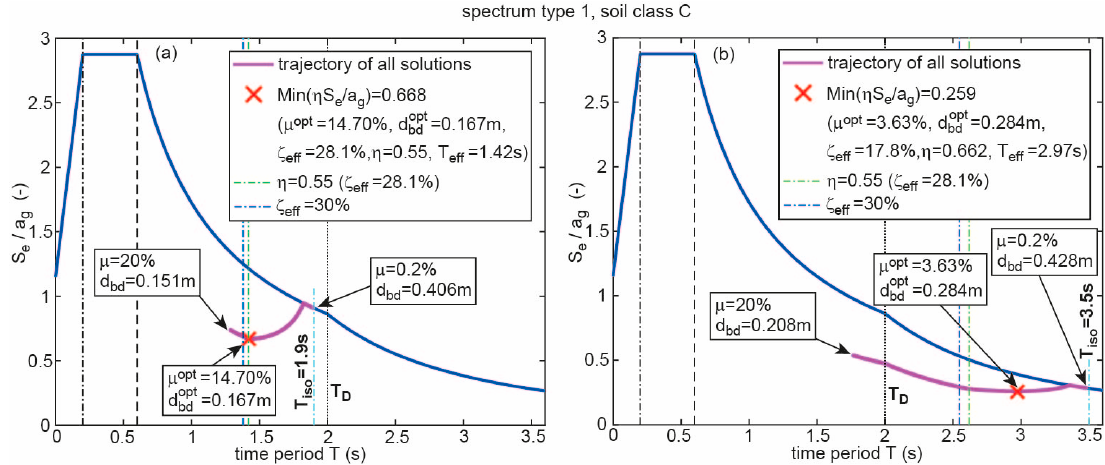
T = 1.9 s and ( b ) T = 3.5 s for spectrum type 1 with iso iso